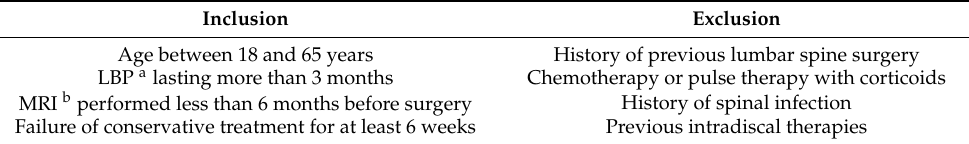
Table 1. Selection Criteria of Patients.